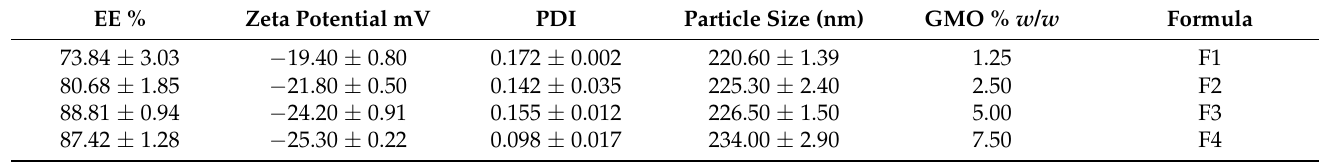
Table 1. GMO content, particle size, PDI, zeta potential, and EE % of gliclazide-loaded cubosomal nanoparticles. EE % Zeta Potential mV PDI Particle Size (nm) GMO % w / w Formula 73.84 ± 3.03 − 19.40 ± 0.80 80.68 ± 1.85 − 21.80 ± 0.50 0.142 ± 0.035 88.81 ± 0.94 − 24.20 ±